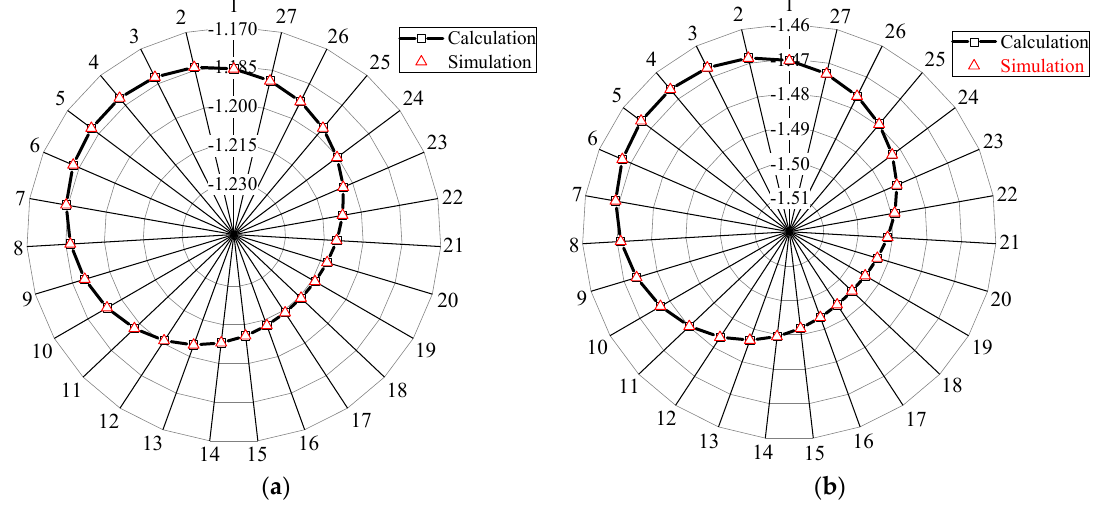
Figure 13. Acceleration distribution of thrust cylinders (unit: mm/s 2 ). ( a ) t = 30 s. ( b ) t = 50 s.